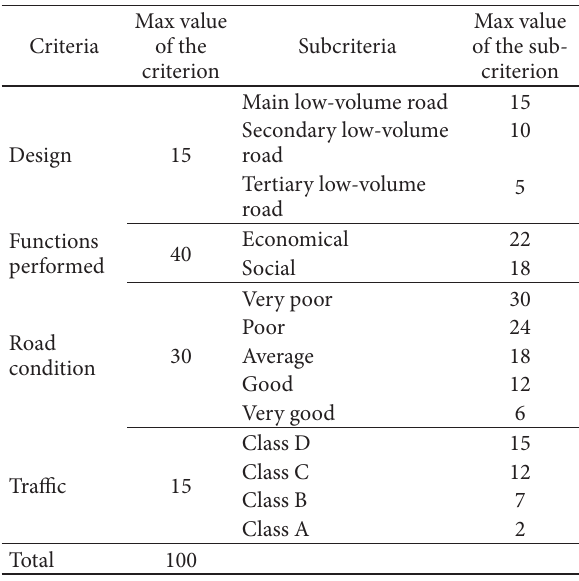
Table 1 . Criteria and subcriteria used to classify low-volume roads